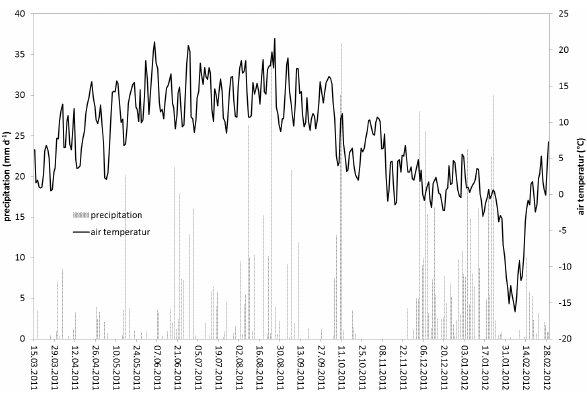
Figure 2 Fig. 2. Overview of the air temperature (black line) and the precipi- tation (bars) over the whole sampling period. The weather data were representative data from the weather station in Braunlage, Harz Mountains,